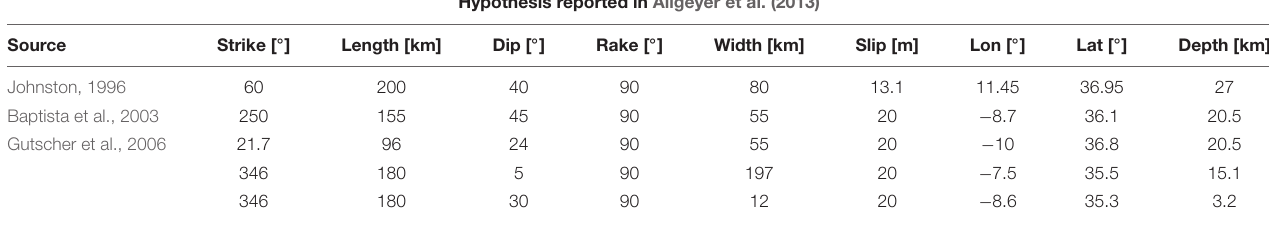
TABLE 6 | Seismic sources simulated in Allgeyer et al. (2013) for the 1755 Lisbon-tsunami. Hypothesis reported in Allgeyer et al. (2013)